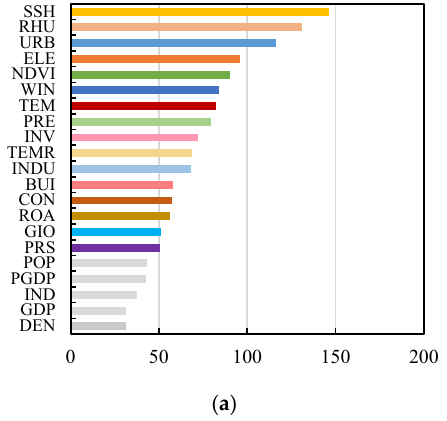
Figure 2. Priority ranking of factors affecting PM 2.5 concentrations in the BTH from 2000 to 2016. ( a ) Ranking of %Inc MSE; ( b ) Ranking of Inc Node Purity. Each variable name is the same as in Table 1.